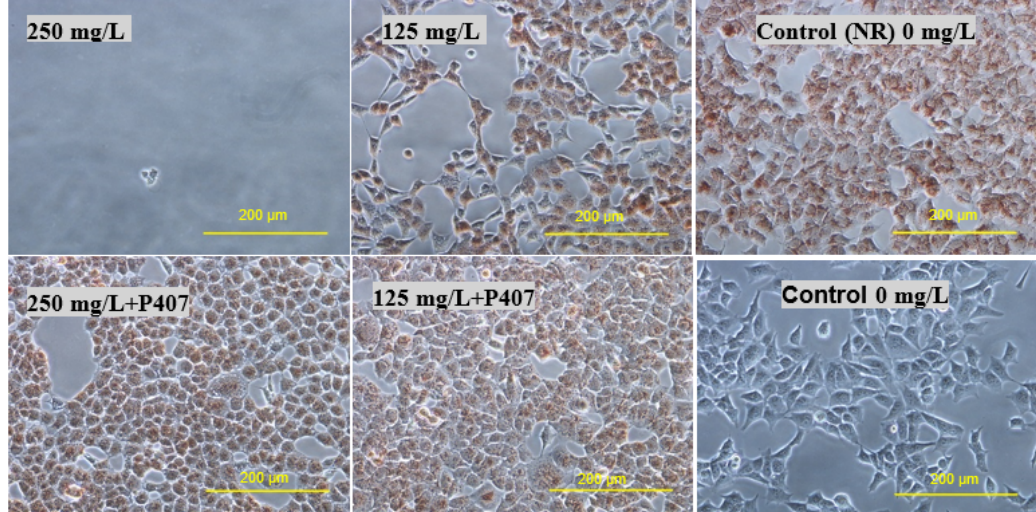
Figure 7. Micrographs of HEK293 cells treated with thymol and Thymol-P407 at a concentration of 125 and 250 mg/Land stained and with NR (×200).